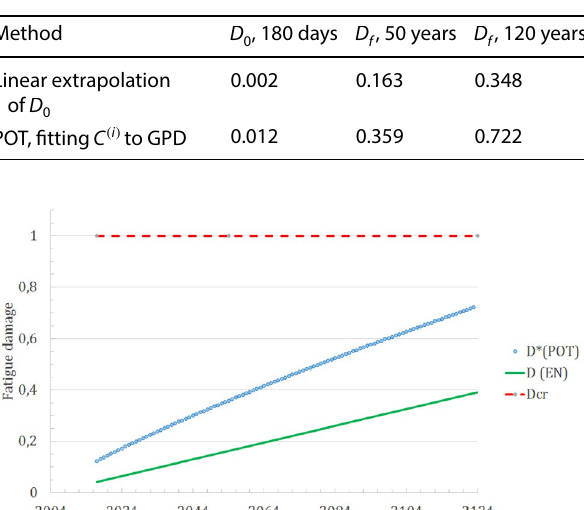
Fig. 12 Fatigue damage accumulation during the operational life of the viaduct, comparison of two